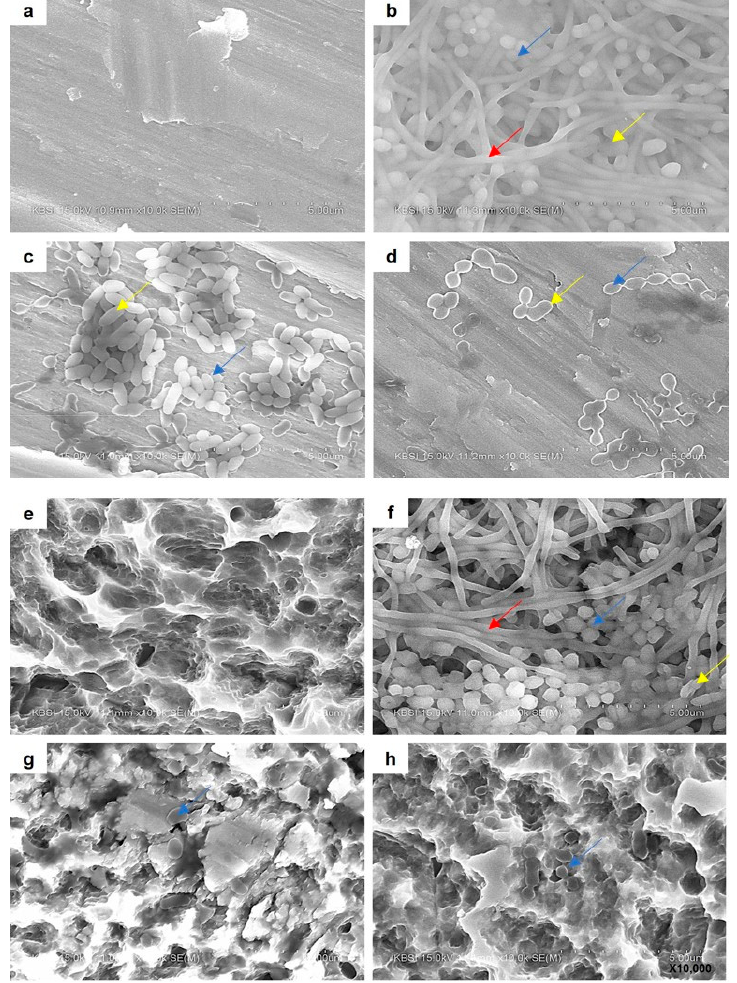
Figure 8. Images obtained using scanning electron microscope of multi-species implant biofilms on titanium discs with ( a – d ) machined or ( e – h ) SLA surface. ( a , e ) Untreated surface; ( b , f ) control; ( c , g ) W. cibaria CMU-treated; ( d , h ) W. cibaria CMS1-treated. Red arrows, spindle-shaped rods; blue arrows, cocci; yellow arrows, rods. Magnification, 10,000×.